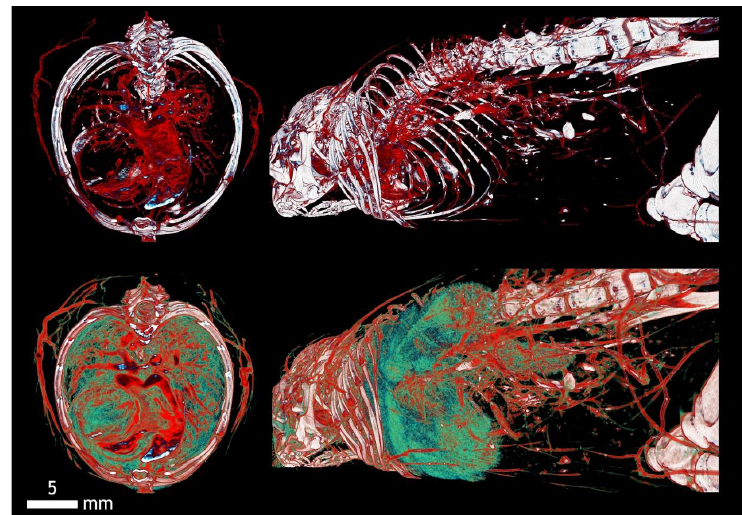
Figure A5. Due to the intravascular contrast of Aurovist, a detailed section of the chest shows the vascular supply of the lungs and its perfusion. Simultaneous view of the bronchial tree allows comparison with respect to the ventilation of individual lung segments. Thus, it is possible to distinguish pathologies in the vascular system in terms of occlusion, embolism, or proliferation in tumor pathology and at the same time monitor the bronchial tree due to air contrast and pathology of reduced aeration in atelectasis and increased air space due to disruption of intrabronchial septum in emphysema.